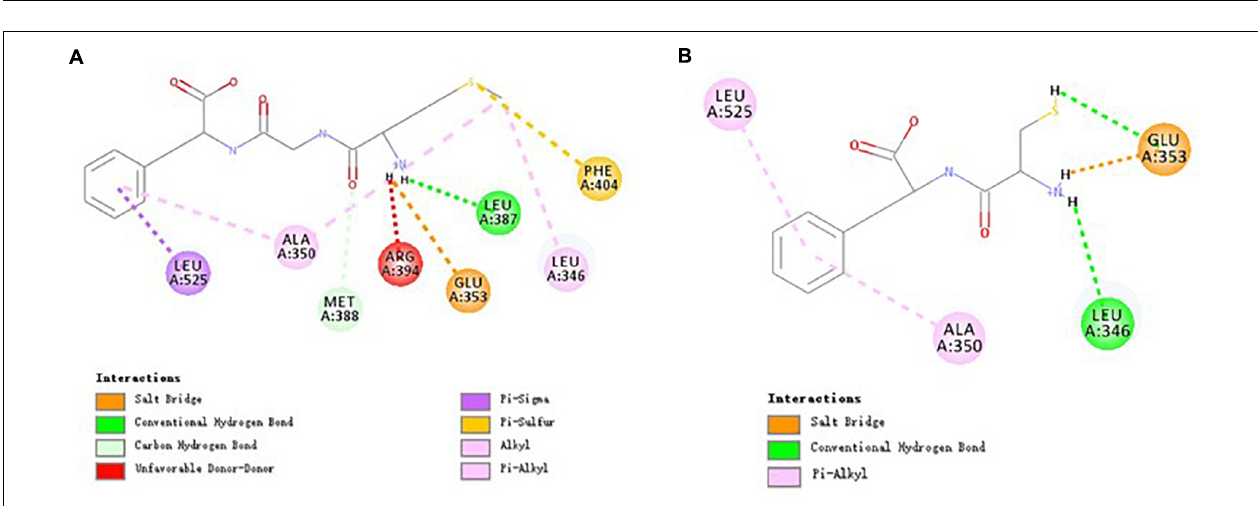
FIGURE 6 | Molecular interactions of MGF, CF, and ER α . (A) Molecular interactions of MGF and ER α . (B) Molecular interactions of CF and ER α .